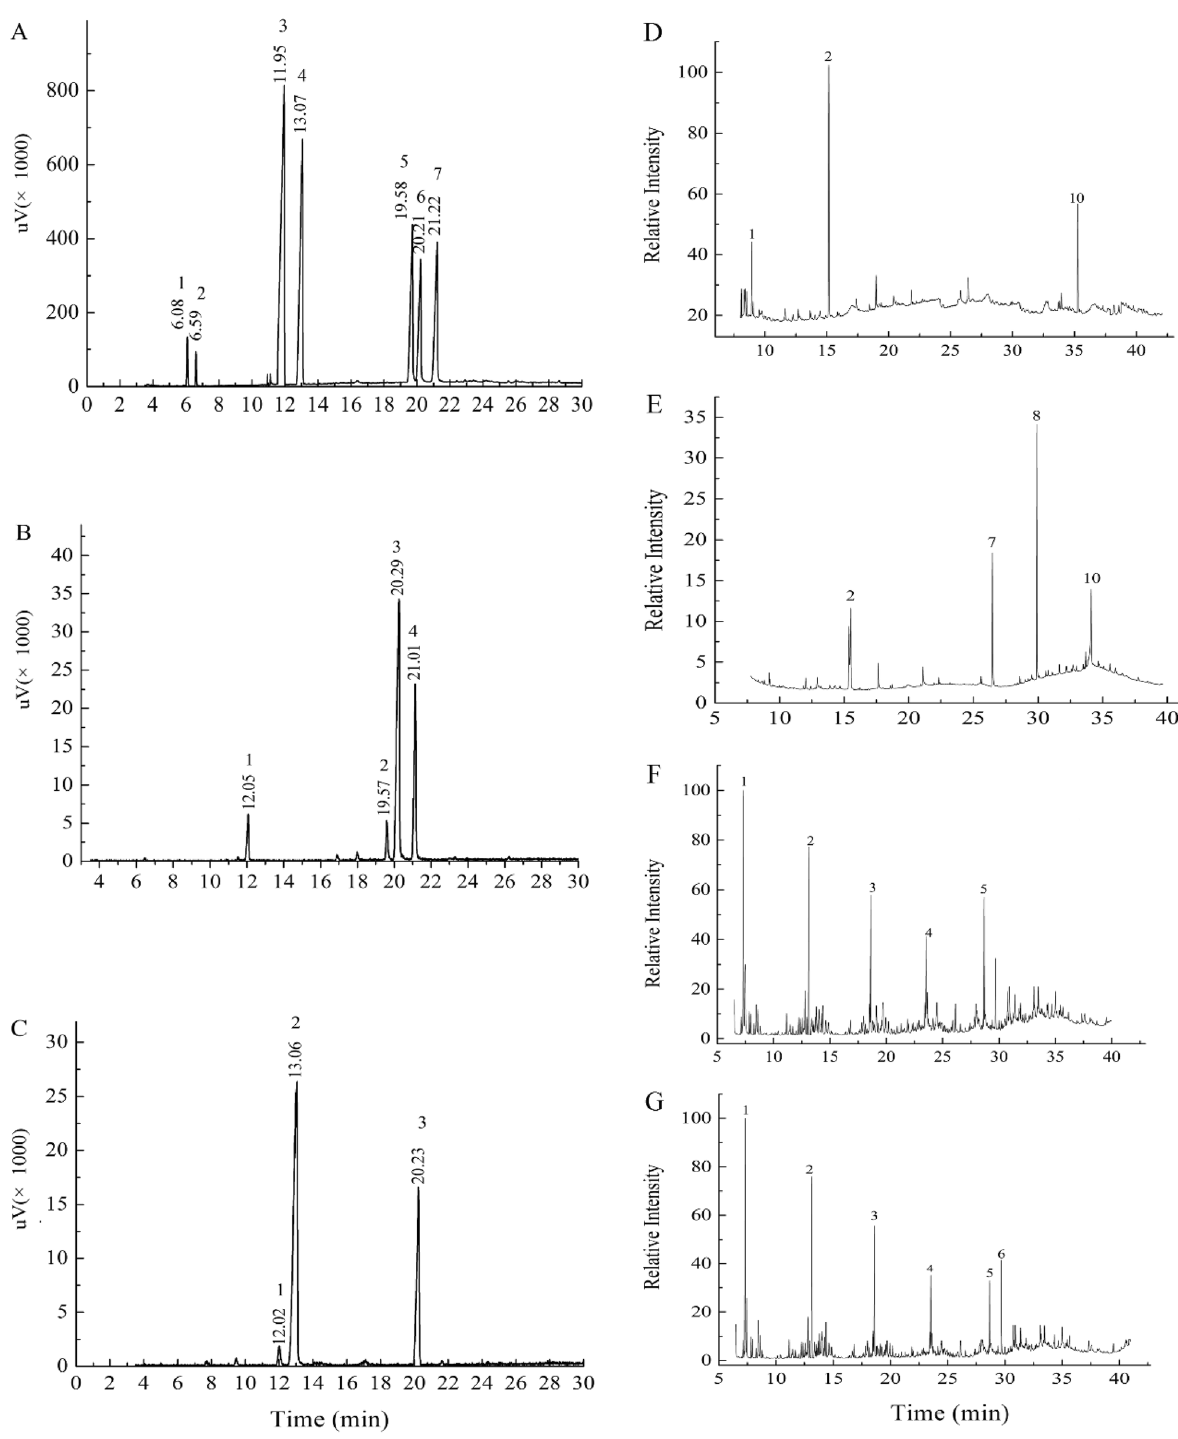
Figure 2. GC–MS spectra of the reference sample. ( A ) HNCP3; ( B ) UNCP4; ( C ) UNCP; ( D ) The total ion chromatogram from methylation analysis of HNCP by GC-MS; ( E ) The total ion chromatogram from methylation analysis of UNCP by GC-MS; ( F ) The total ion chromatogram of the methylated product of HNCP3; ( G ) The total ion chromatogram of the methylated product of